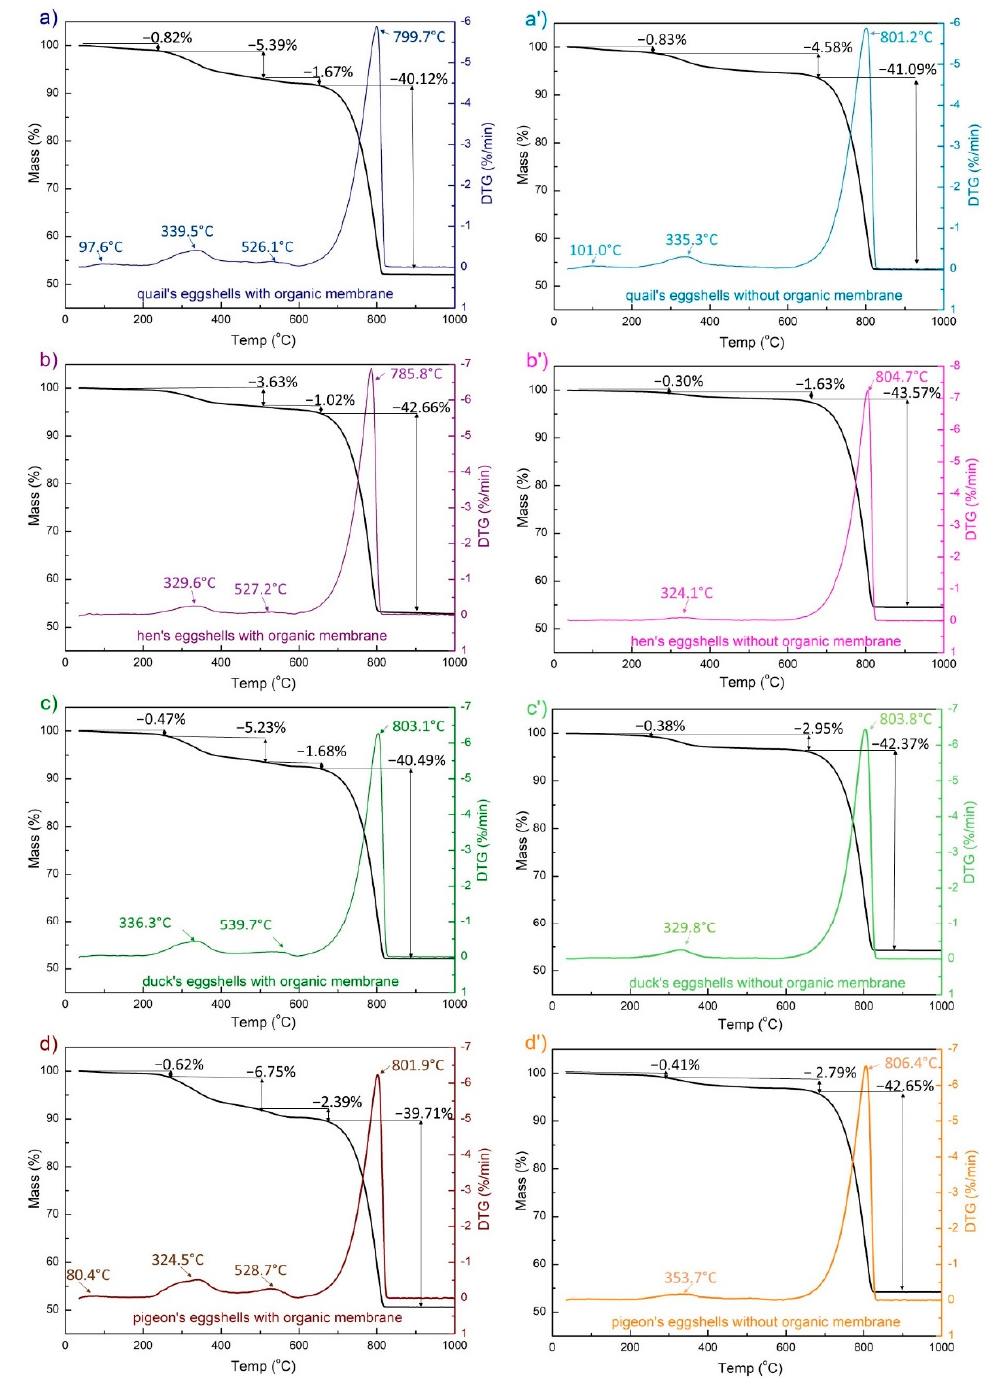
Figure 1. Results from the thermal analysis: TG (black) and DTG (colored) curves of different poultry species eggshell materials with ( a – d ) and without ( a’ – d’ ) the eggshell membrane (EMS). The elemental composition of each eggshell was determined using the ICP-OES techniques (Figures 2 and 3). Each shell was composed mostly of calcium (around 40% w / w ), magnesium (less than 0.5% w / w ) and tiny amounts of copper and zinc. After the organic membrane removal, the calcium content increased by about 2%, which is in line with the results of the thermal analysis. The smallest amount of this element was detected for quail eggshells, whereas the largest one for the hen eggshell